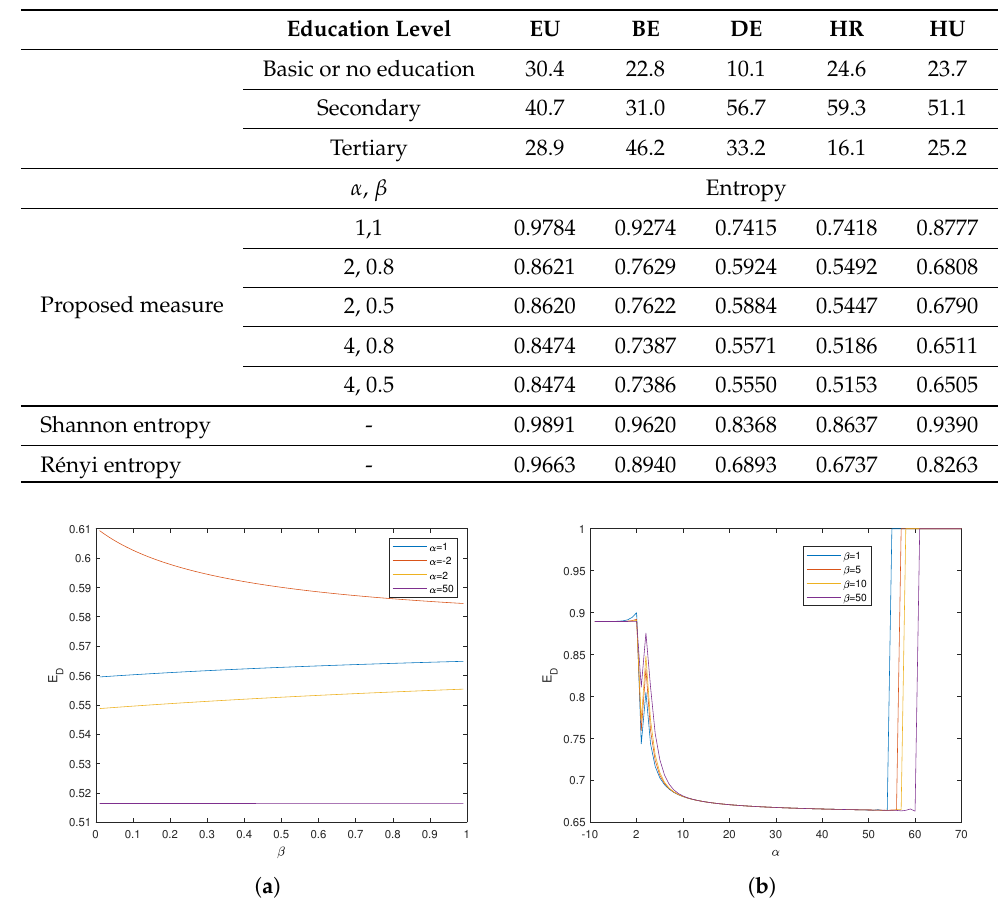
Table 5. Entropies for the distribution of education level in the EU and four EU countries.